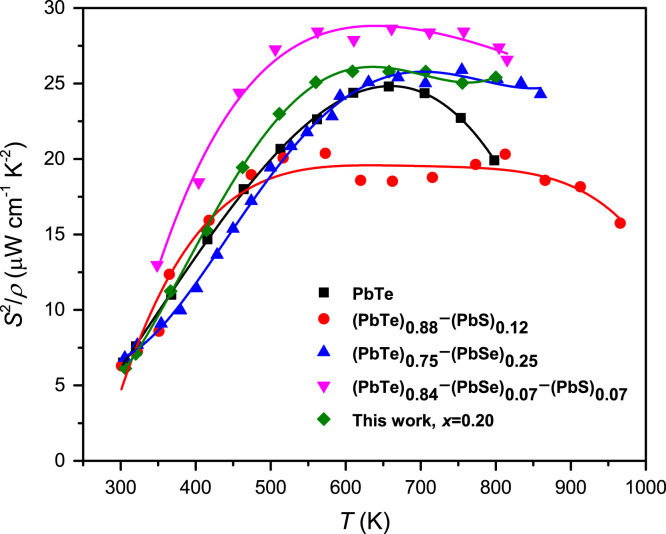
Comparison of power factors for (PbTe0.95Se0.20)(PbS)0.05 with (PbTe)0.88(PbS)0.12[2], (PbTe)0.75(PbSe)0.25[3], and (PbTe)0.84(PbSe)0.07(PbS)0.07[4] compounds.